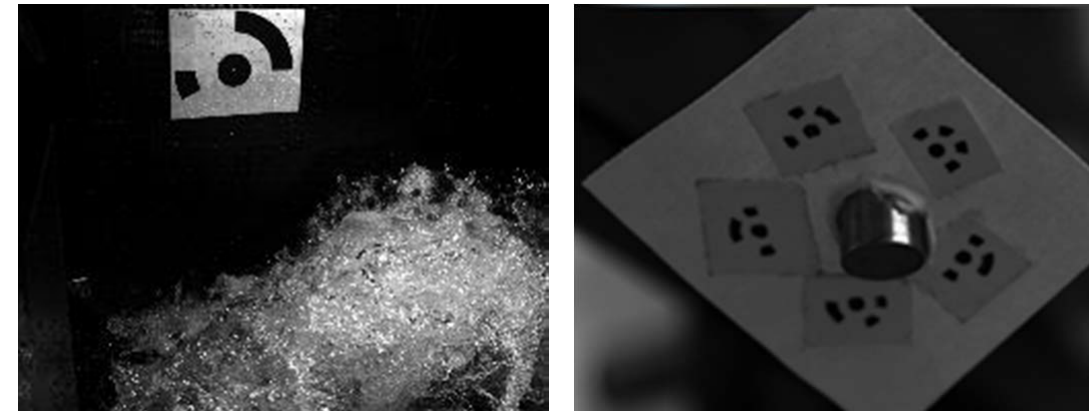
Figure 19. Placing a marker outside the center of events in our experiment (left) and placing a marker in the center of events in the experiment (right)